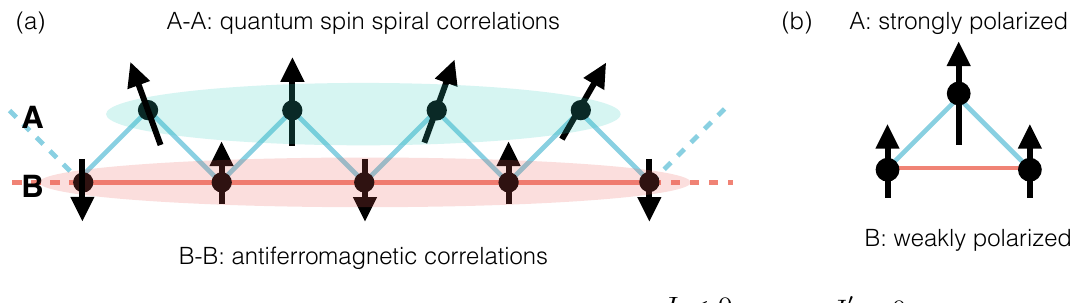
Figure 1: Sketch of the FM-AFM sawtooth chain and the proposed magnetic order in the ferrimagnetic phase. The apical and basal sites are labeled as “A” and “B”, respec- tively. (a) Schematic visualization of the spin-spin correlations. (b) Visualization of the spin polarization pattern. Both the quantum spin spiral (A-A) and the AFM order (B-B) can only be detected via the connected spin-spin correlations and not via the